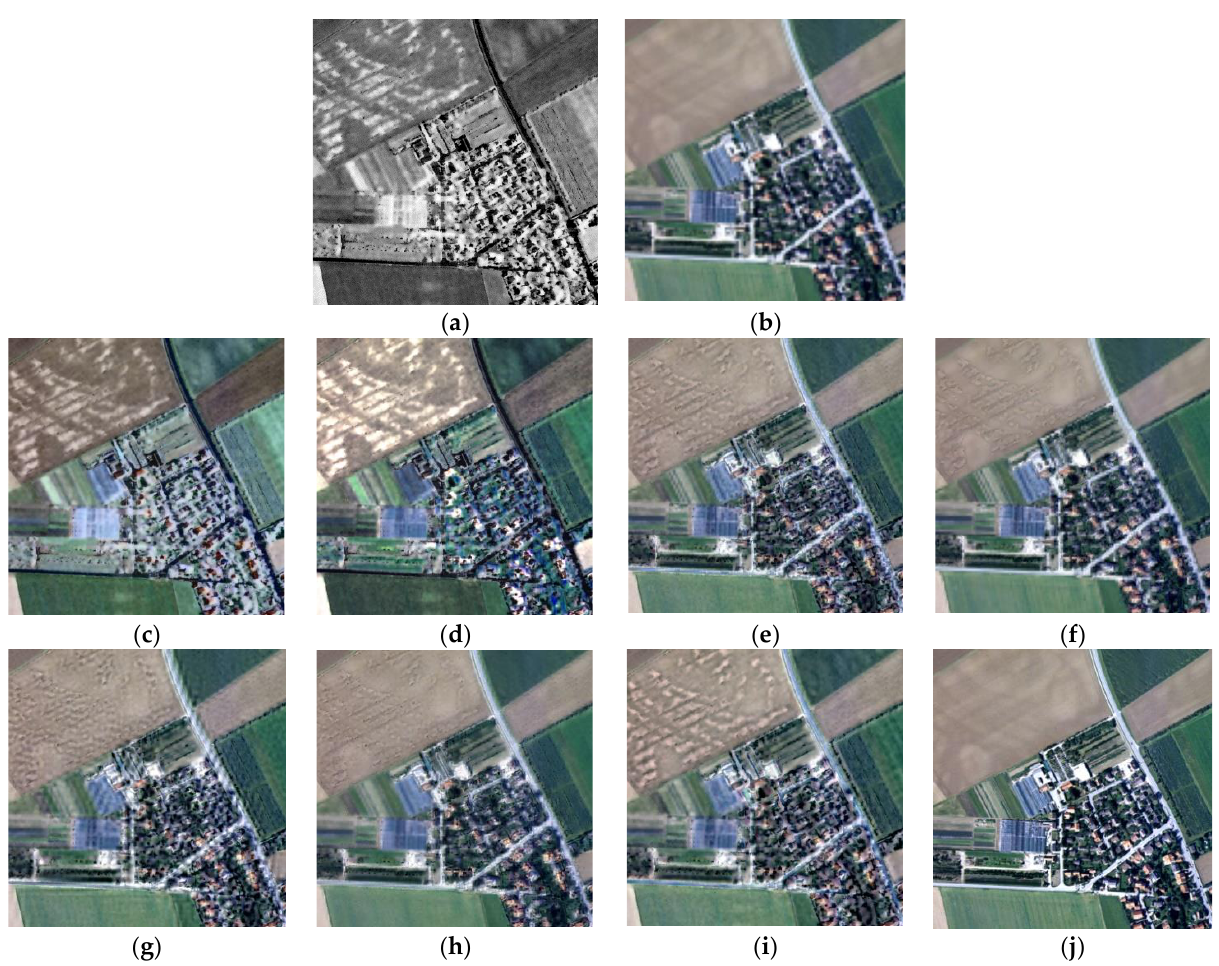
Figure 6. Fusion results of different methods in area 3. ( a ) HR SAR image; ( b ) up-sampled LR multispectral image; ( c ) IHS fusion; ( d ) BTH fusion; ( e ) LP-based fusion; ( f ) AWLPR fusion; ( g ) IW fusion; ( h ) GFTD fusion; ( i ) proposed LPSR fusion; ( j ) original HR multispectral image.